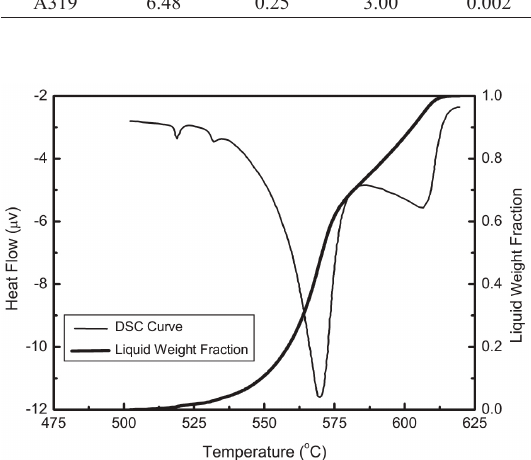
Table 1. Chemical composition of A319 aluminum alloys (wt.-%). Alloy